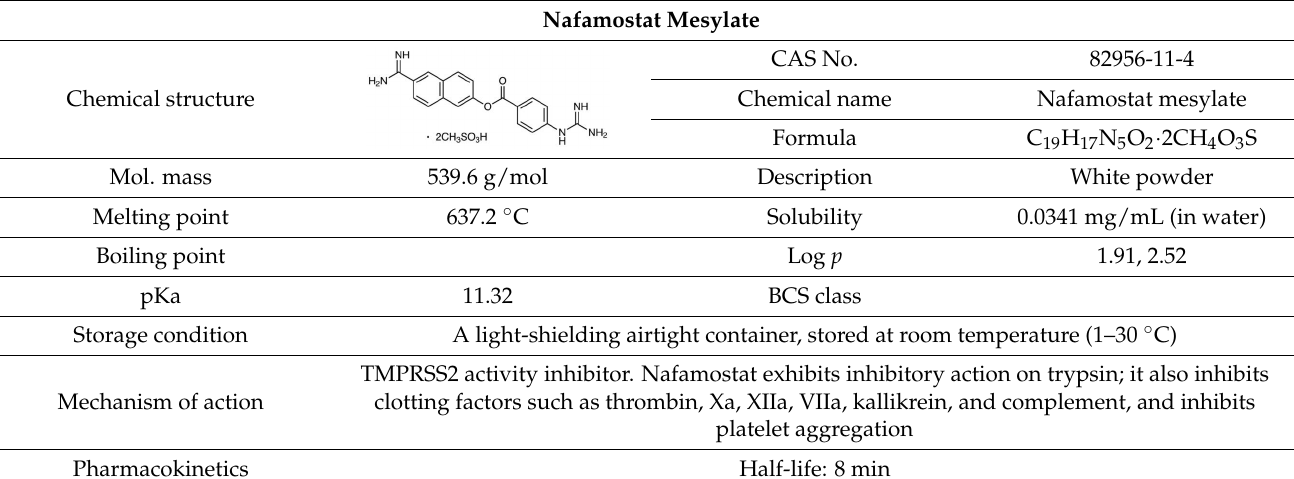
Table 1. Characteristics of nafamostat mesylate.